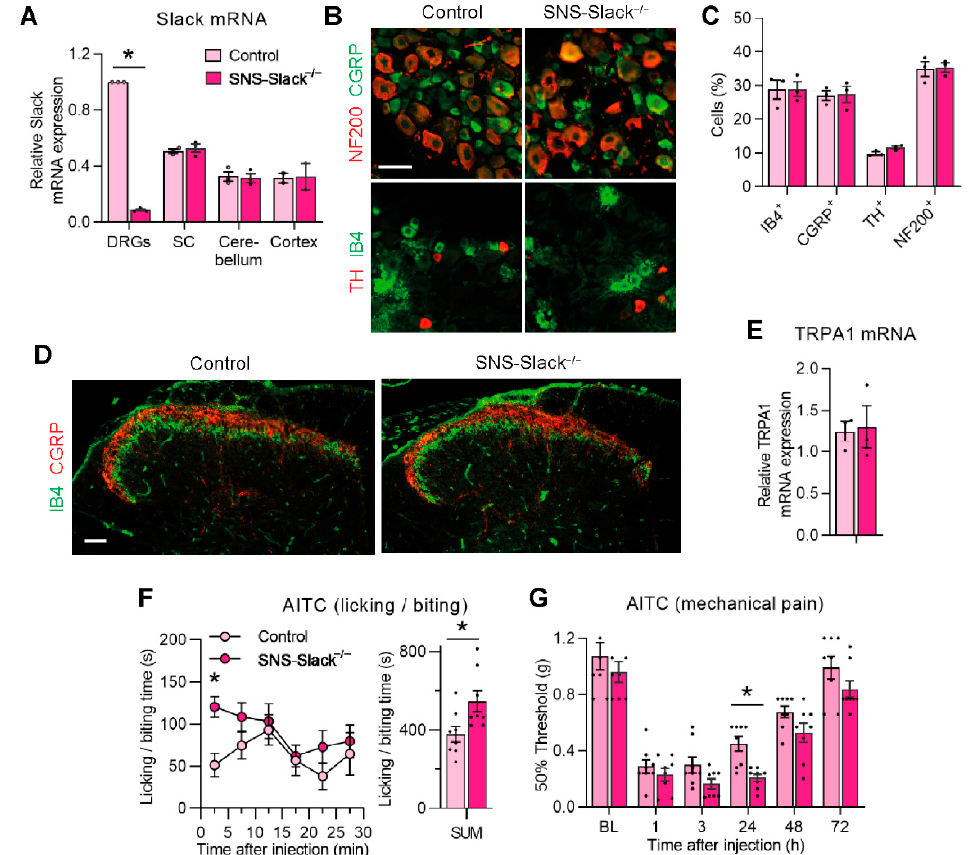
Figure 2. SNS-Slack − / − mice display increased AITC-evoked pain behavior. ( A ) Quantitative RT- PCR in lumbar DRGs, lumbar spinal cord, cerebellum and prefrontal cortex revealed that Slack mRNA is selectively reduced in DRGs of SNS-Slack − / − mice ( p = 0.0002; n = 3 mice per group). ( B , C ) Expression pattern and percentages of DRG neurons binding IB4 (2207 cells from 4 mice per group were counted), or immunoreactive for CGRP (2110 cells from 4 mice per group were counted), TH (839 cells from 4 mice per group were counted), NF200 (2751 cells from 4 mice per group were counted), are similar in SNS-Slack − / − and control mice. Scale bar, 50 µ m. ( D ) The distribution of central terminals of primary afferents immunoreactive for CGRP or binding IB4 in the dorsal horn appears normal in SNS-Slack − / − mice. Scale bar, 50 µ m. ( E ) Quantitative RT-PCR revealed that TRPA1 mRNA expression in lumbar DRGs is similar in control and SNS-Slack − / − mice ( p = 0.8638; n = 3 mice per group). ( F ) Time course of paw licking and biting (left; p = 0.0148 for the 0–5 min period) and the sum of licking and biting time over 30 min (right; p = 0.0238; n = 8 mice per group) after intraplantar injection of AITC in control and SNS-Slack − / − littermates. ( G ) Time course of mechanical hypersensitivity after intraplantar AITC injection. Two-way ANOVA, effect of genotype ( p = 0.0126) with Sidak’s multiple comparisons test ( p = 0.0346, representing comparisons between genotypes for the 24 h time point); n = 8 mice per group. Data are presented as mean ± SEM. * p < 0.05.